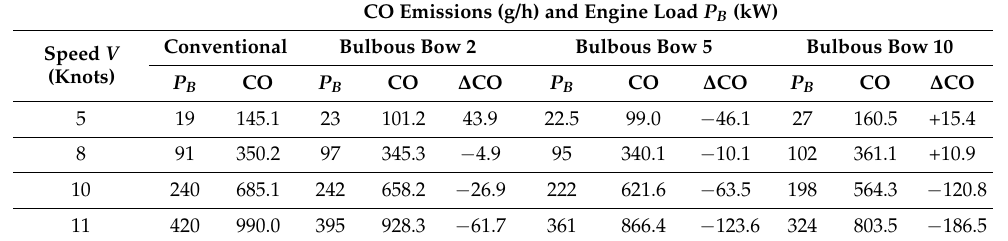
Table 7. CO emissions (g/h) and engine load P B (kW) at various vessel speeds for the analysed bulbous bows.